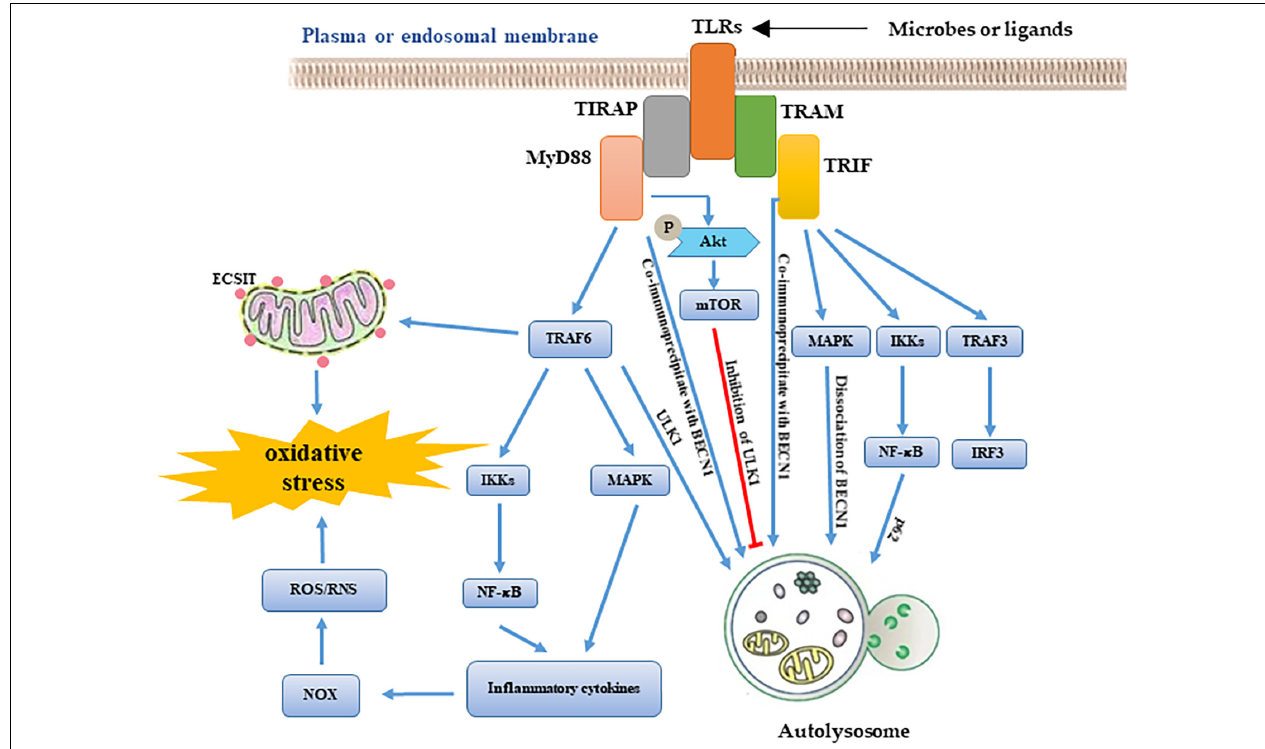
FIGURE 2 | Schematic roles of TLRs signaling in autophagy and mitochondrial homeostasis. According to the availability of adaptor molecules, activation of TLRs signaling induces MyD88-TRAF6 pathway and TRIF pathway. On one hand, TLRs downstream signaling molecules affect mitochondrial homeostasis via regulating ROS production. On another hand, these molecules are also involved in the formation of autolysosome through regulates activity of autophagy-related